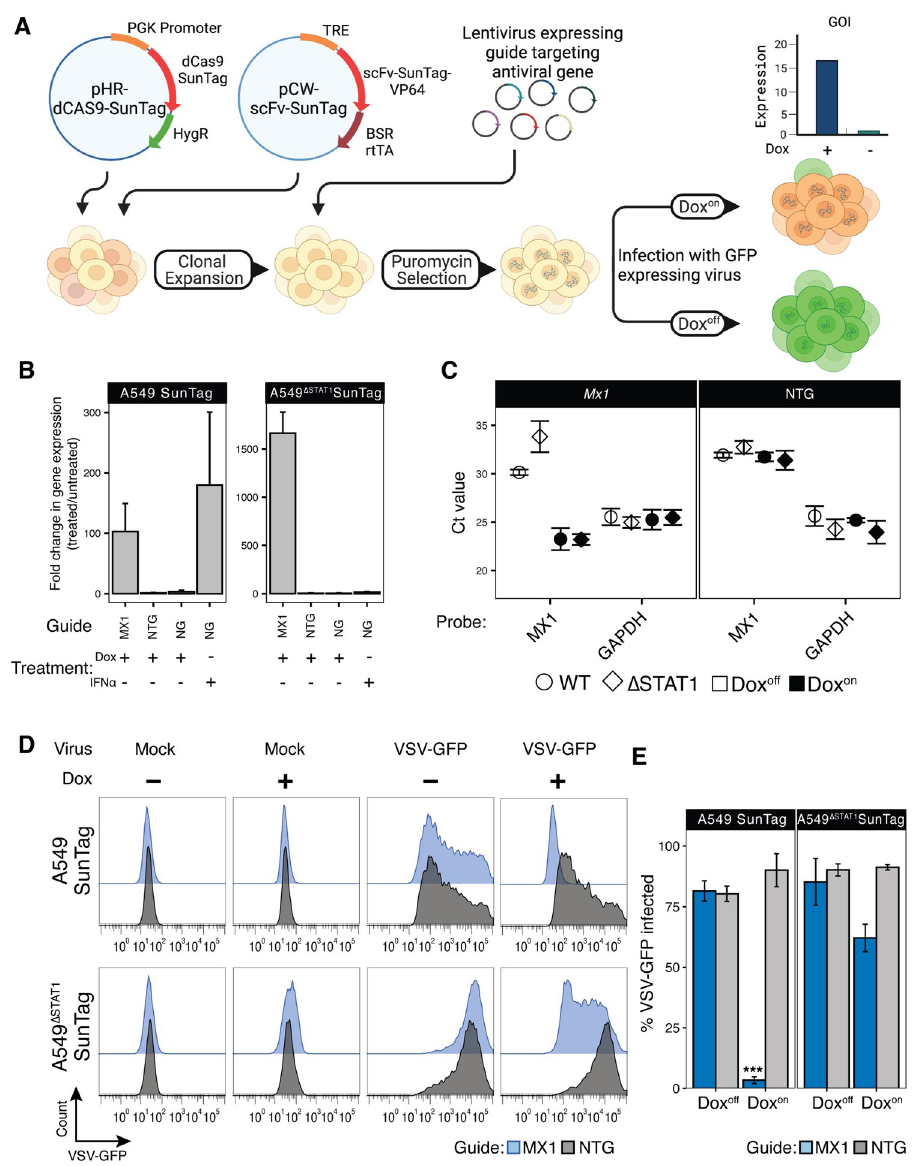
Fig 1. Inducible CRISPRa system demonstrates Dox-regulated, gRNA-specific gene expression and functional block of VSV-GFP infection in isogenic A549 and A549 Δ STAT1 cell lines. (A ) Schematic of the Dox-inducible CRISPRa system for assessing antiviral ISG activities. (B) qRT-PCR analysis for MX1 mRNA in A549-SunTag and A549 Δ STAT1 -SunTag cells transduced with MX1 gRNA, non-targeting gRNA (NTG), or in cells with no gRNA (NG), treated with Dox or IFN. Fold change gene expression in Dox on cells relative to Dox off cells calculated using the ΔΔ Ct method with normalization to GAPDH . (C) Mean qRT-PCR threshold cycle (Ct) values for MX1 and GAPDH mRNA in A549-SunTag and A549 Δ STAT1 -SunTag cells transduced with MX1 gRNA or NTG gRNA (NTG). Error bars indicate ± SD. (D) Representative flow cytometry histograms for GFP fluorescence in A549-SunTag and A549 Δ STAT1 - SunTag transduced with MX1 gRNA (blue) or NTG (gray) gRNA and infected with VSV-GFP (M.O.I. = 1, 24hr). (E) Percent VSV-GFP-positive cells by flow cytometry quantified for n = 3 biological replicates. Bars represent mean ± SD of GFP positive cells across all replicates. Paired ratio Student’s t-test, ��� p <